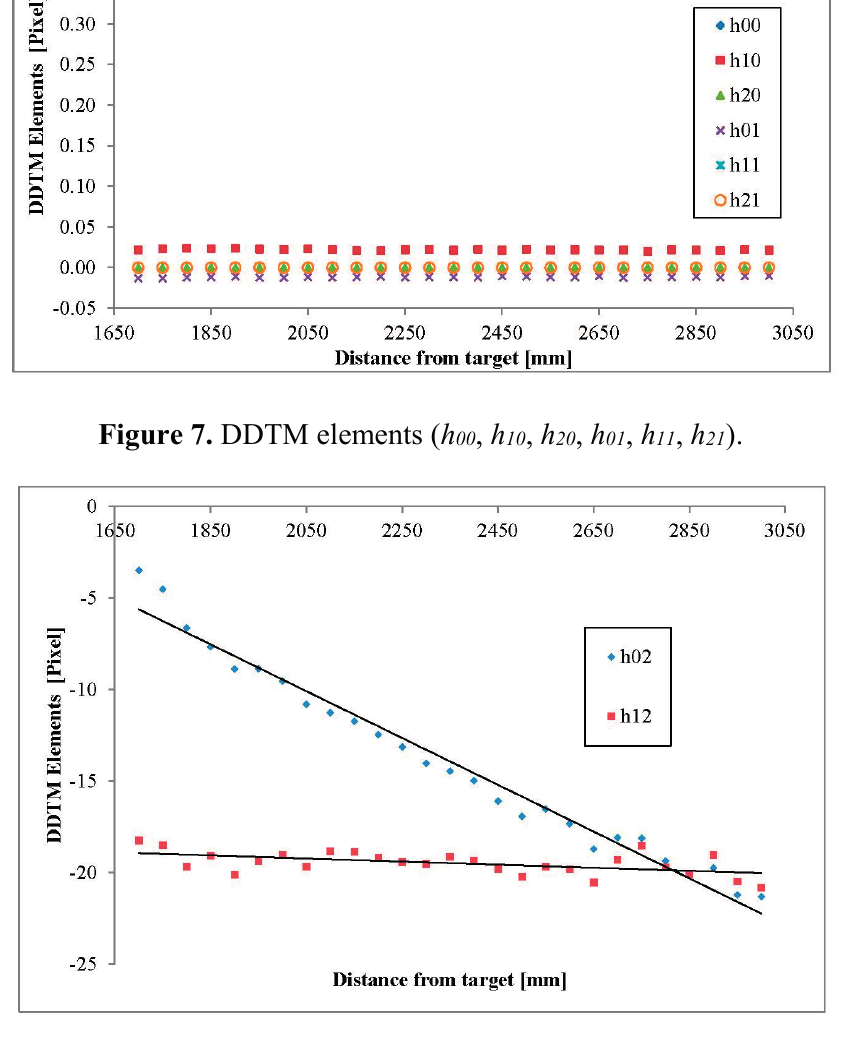
Figure 8. DDTM elements ( h 02 , h 12